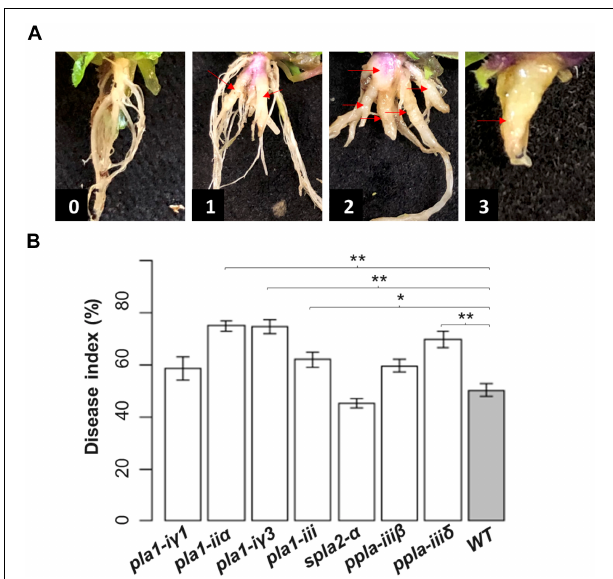
FIGURE 2 | Evaluation of reaction of seven pla mutants and wild-type (Columbia) Arabidopsis to inoculation with Plasmodiophora brassicae pathotype 3H. (A) The rating scale used to evaluate clubroot disease severity, where: 0 = no galls, 1 = galls mainly on the lateral roots, 2 = obvious galls on both the primary and lateral roots with a moderately reduced root system, and 3 = large galls on the primary roots with a significantly reduced root system. The individual severity ratings were used to calculate a disease index. (B) The disease index on the seven pla mutants and the wild-type Columbia 26 days after inoculation with P. brassicae . Values are means ± SE of six independent replicates with 24 plants per replicate. The asterisks indicate significant differences at p < 0.05 (*) and p < 0.01 (**) compared with the wild-type, based on the Dunnett’s test in R.